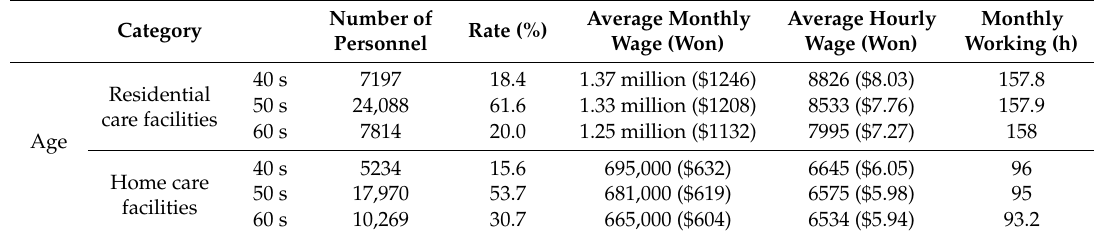
Table 4. Average wage and monthly average working hours based on